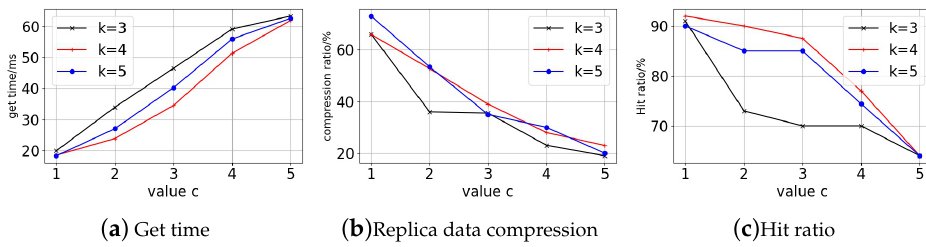
Figure 11. Particion node = 100. ( a ) Get time. ( b ) Replica data compression. ( c ) Hit